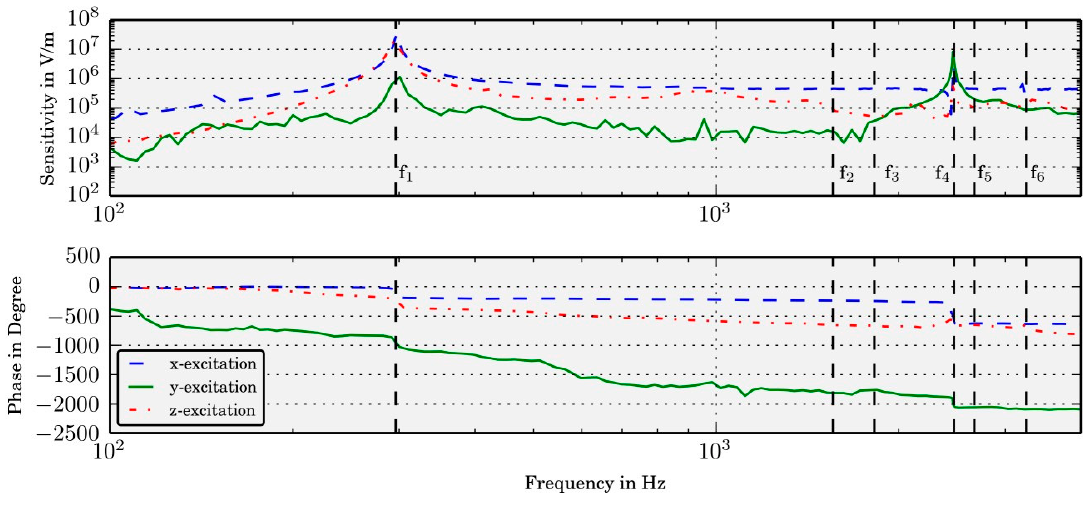
Figure 5. The transfer characteristic of the optomechanical transducer reveals that the in-plane vibration modes ( f 1 , f 4 , f 6 ) are in very good agreement with the simulated ones. No out-of-plane modes ( f 2 , f 3 , f 5 ) are observable in the transducer’s output signals. This indicates that the readout has a negligible cross-sensitivity regarding such out-of-plane